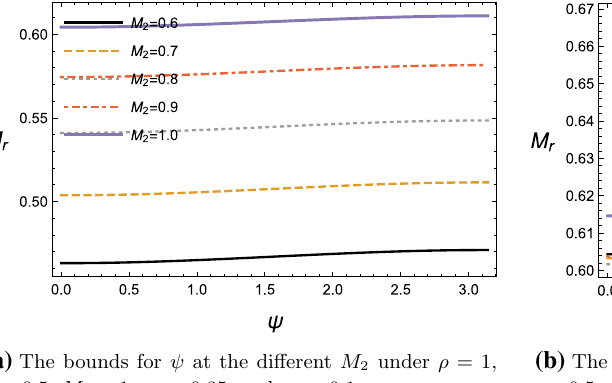
( a ) The bounds for M 2 at ρ = 1, g = 0 . 5, M 1 = 1, a 1 = 0 . 35, and ψ = 0. Fig. 8 The upper bound on the gravitational radiation for a positive ρ